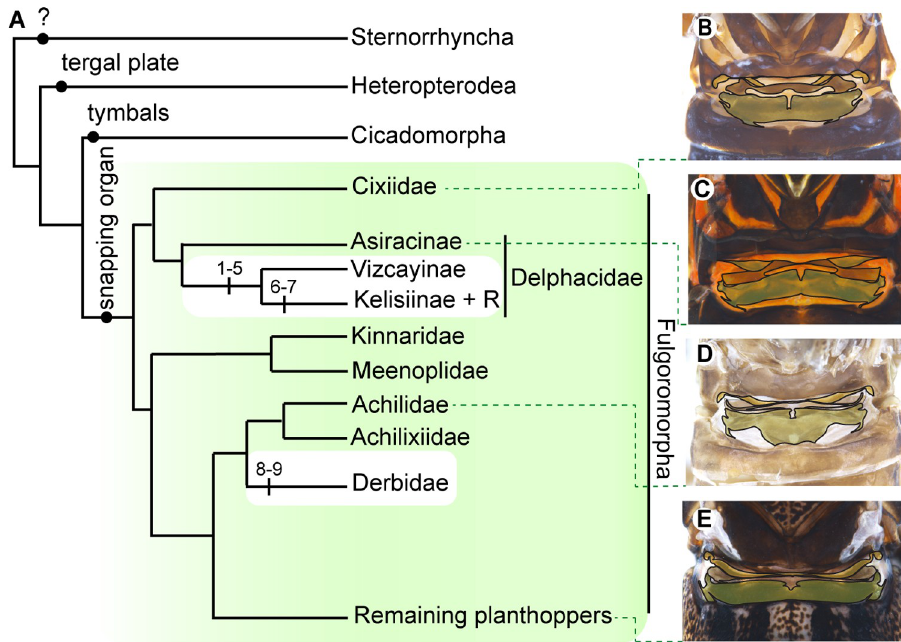
Fig 3. The snapping organ likely evolved once in the planthoppers. (A) Systematic distribution of the snapping organ (green, Fulgoromorpha) indicates a single origin at the root of planthopper phylogeny. White spaces within planthoppers indicate modification of snapping organs in the non-Asiracinae delphacids and the Derbidae. Numbers within the white spaces represent character states underlying the morphological transformations of the snapping organs in these planthoppers (see S4 Table). Other types of known abdominal vibrational organs are shown in the outgroups. Dorsal views (not to scale) of the snapping organs of (B) male Pentastira sp. (Cixiidae), (C) male Asiraca clavicornis (Delphacidae: Asiracinae), (D) male Cixidia skaloula (Achilidae), and (E) female Caliscelis wallengreni (Caliscelidae). Green dashed lines link snapping organs to their respective families; the branch of the tree labelled ‘remaining planthoppers’ also includes our model species A . bilobum (Issidae). Phylogenetic reconstruction is based on previous studies [29, 30]. R, remaining delphacid